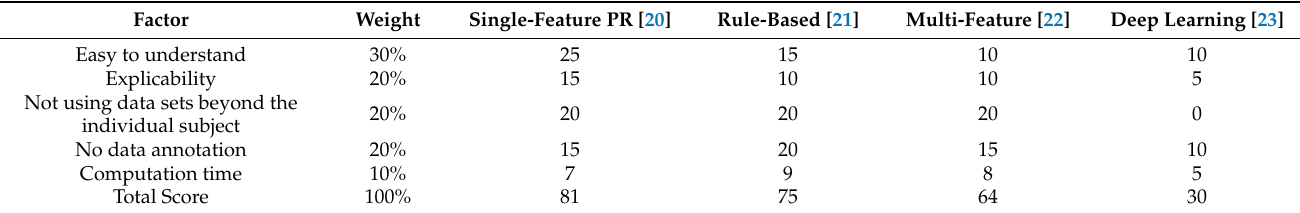
Table 2. Design matrix to select suitable AI algorithm technique for